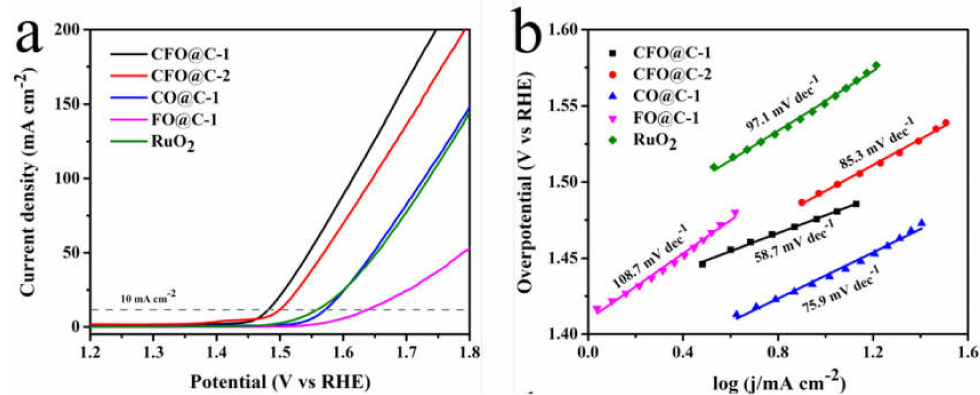
Figure 5. OER activity of mesoporous CoFe-based nanomaterials in 0.1 M KOH. ( a ) LSV curves and ( b ) Tafel slopes for CFO@C-1, CFO@C-2, CO@C-1, FO@C-1 and RuO 2 . Copyright 2020